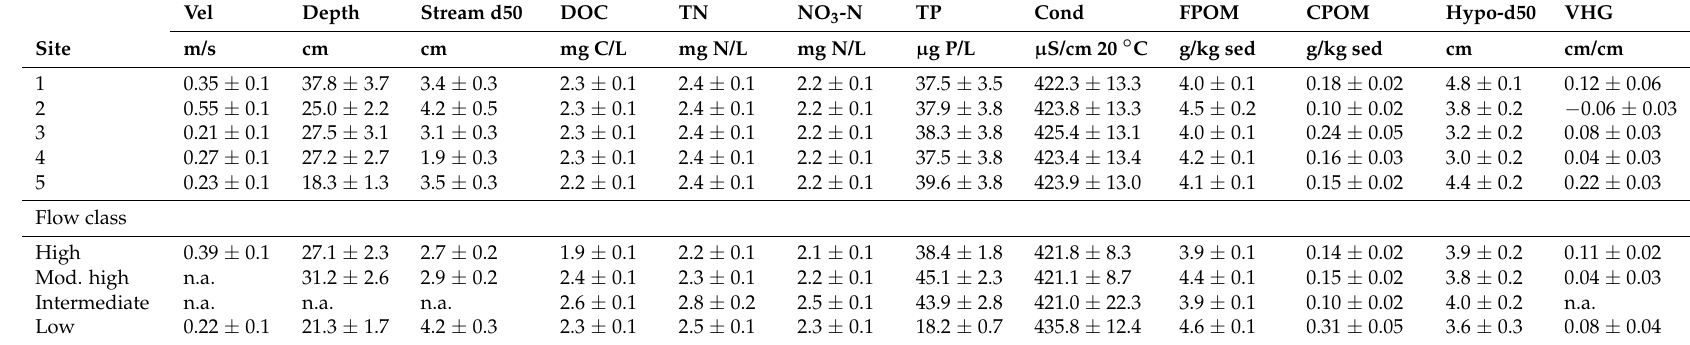
Table 2. Physico-chemical and hyporheic zone characterization of the study sites and flow classes (average ± standard